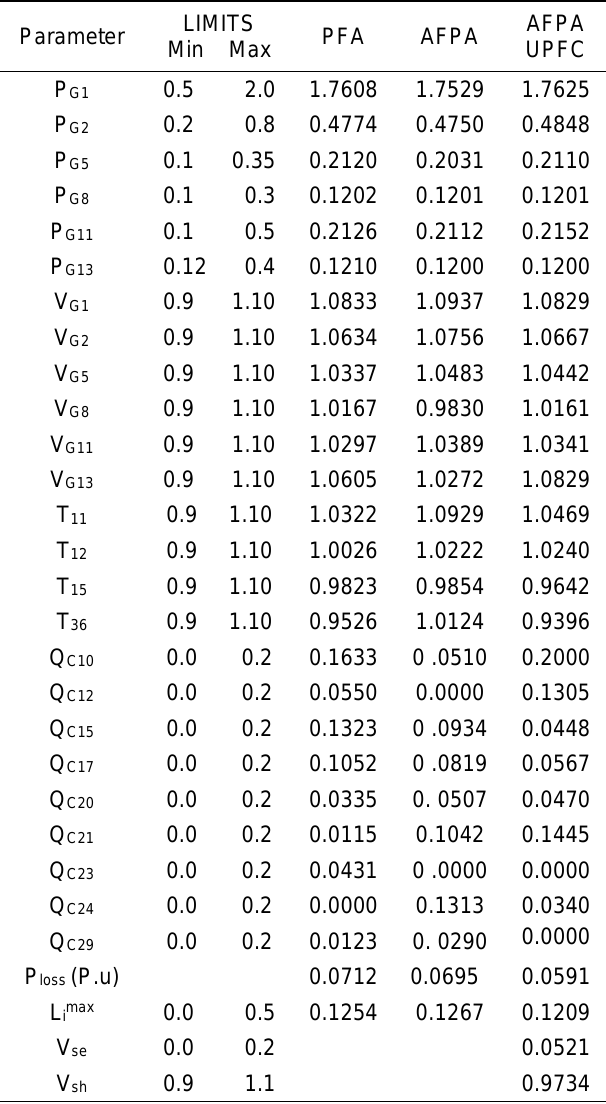
Table 5. OPF Results with Power loss as an objective